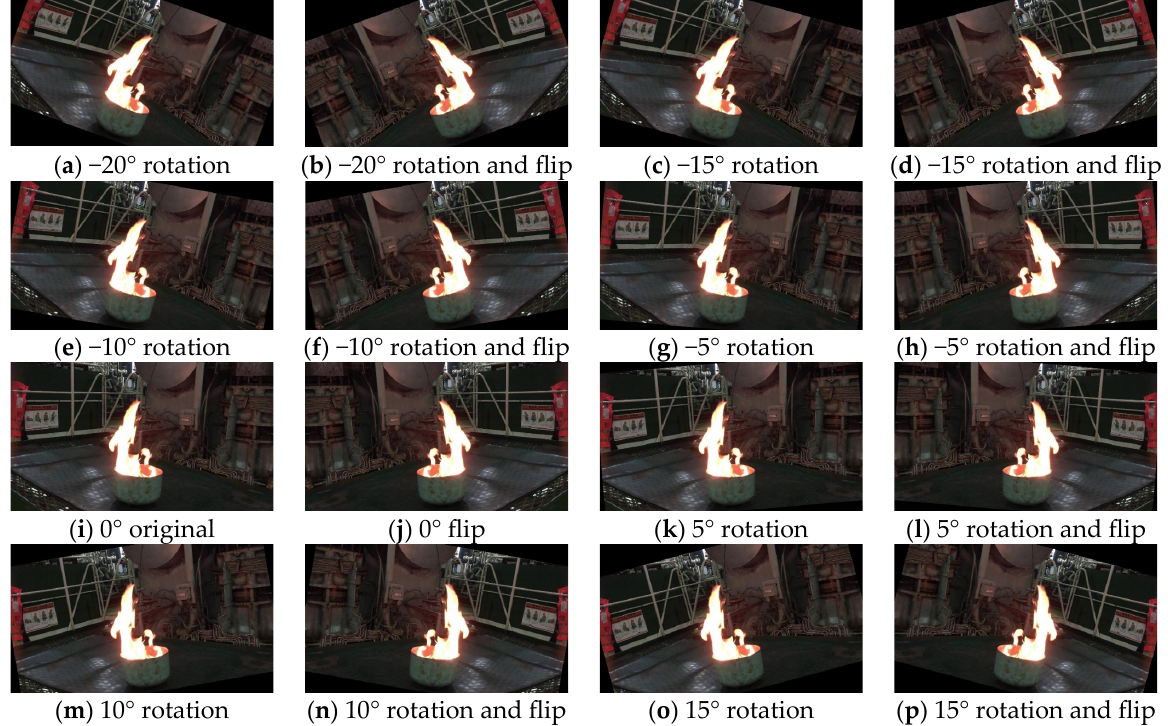
Figure 7. Sample of the dataset augmentation. In order to increase the learning data, it was rotated and horizontal flipped from − 20° to 15°.